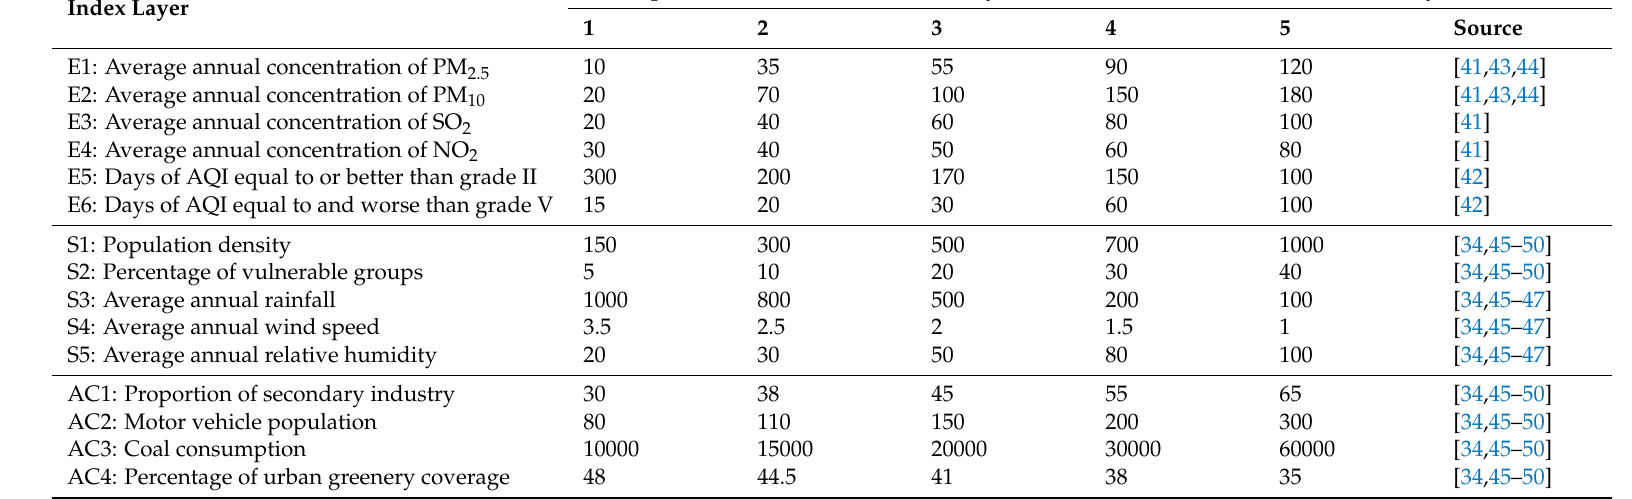
Table 3. The benchmark of atmospheric environment vulnerability assessment